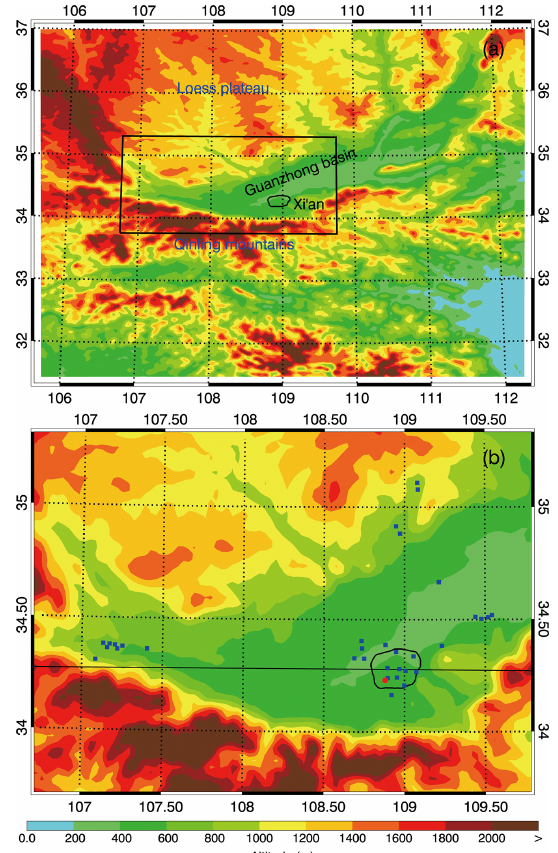
Figure 1. (a) WRF and WRF-CHEM model simulation domain with topography and (b) geographic distributions of ambient moni- toring stations. In panel (b) , the blue filled squares are the ambient monitoring sites, the red filled circle is the IEECAS site, and the cross line is the position of the cross section shown in Fig. 7. The color contour in both panels denotes the terrain